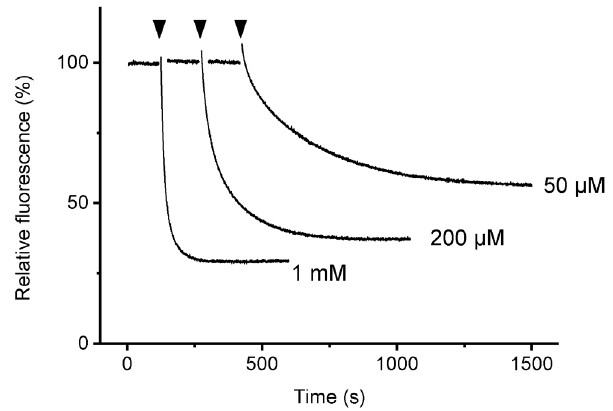
Figure 2. Time course of fluorescence change of a 3 b 3 c RW upon addition of ATP. MgATP was added at the times indicated by the arrowheads. Final ATP concentration in each measurement is shown on the right. Fluorescence is normalized to that before the addition of